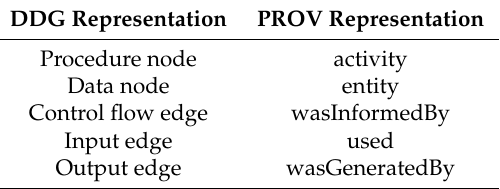
Table 3. DDG and PROV